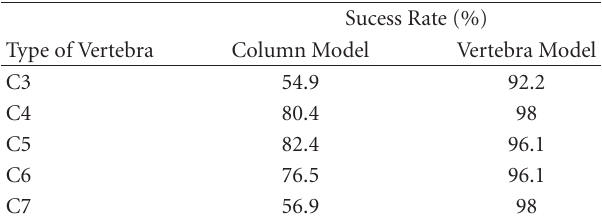
Table 1: Success rate of segmentation with a sample of 75